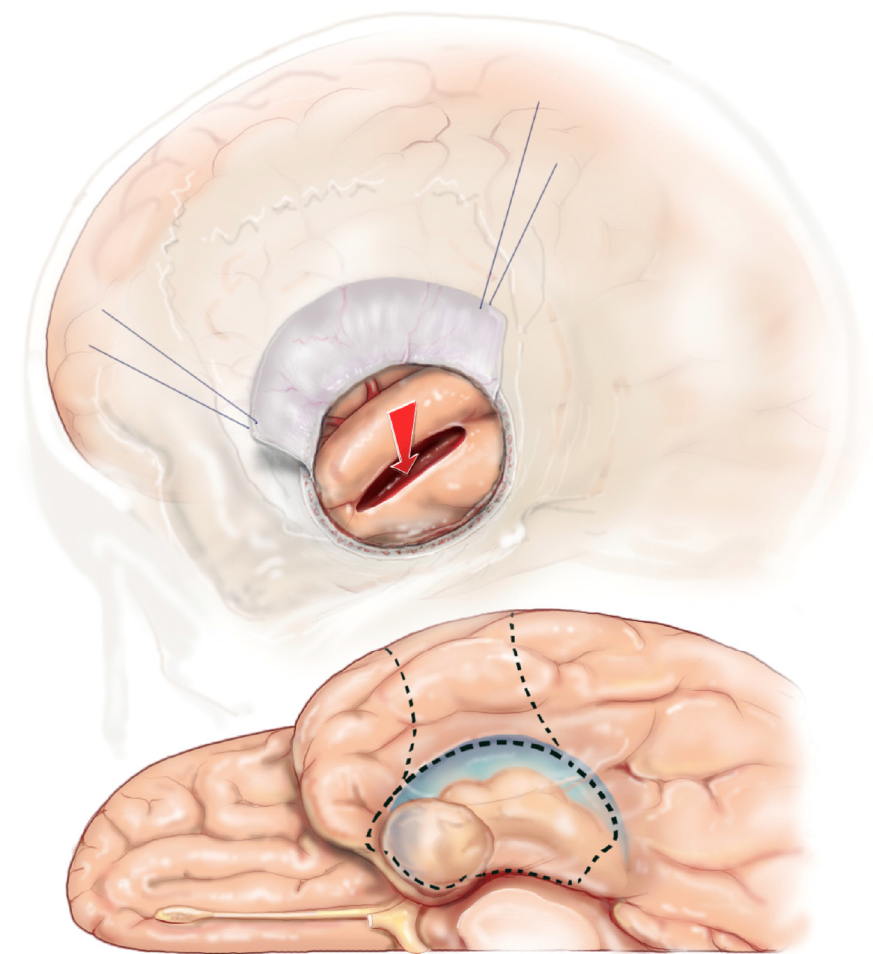
Figure 11. Reprinted from Journal of Clinical Neuroscience 17 (9), Boling W, Minimal access keyhole surgery for mesial temporal lobe epilepsy, 1180–1184, Copyright 2010, with permission from Elsevier, [59]. The corticectomy and trans-T2 trans-ventricular approach to resection of the mesial temporal structures is identical to the approach via a standard scalp incision and cranial opening.